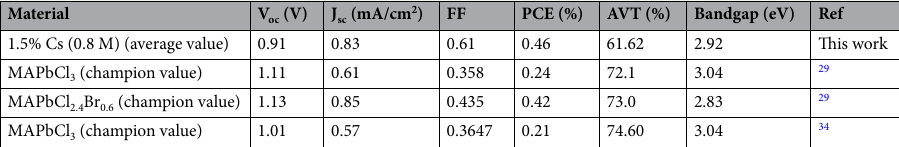
Table 2. Comparison of PV performances for different reported clear solar cells under one sun.